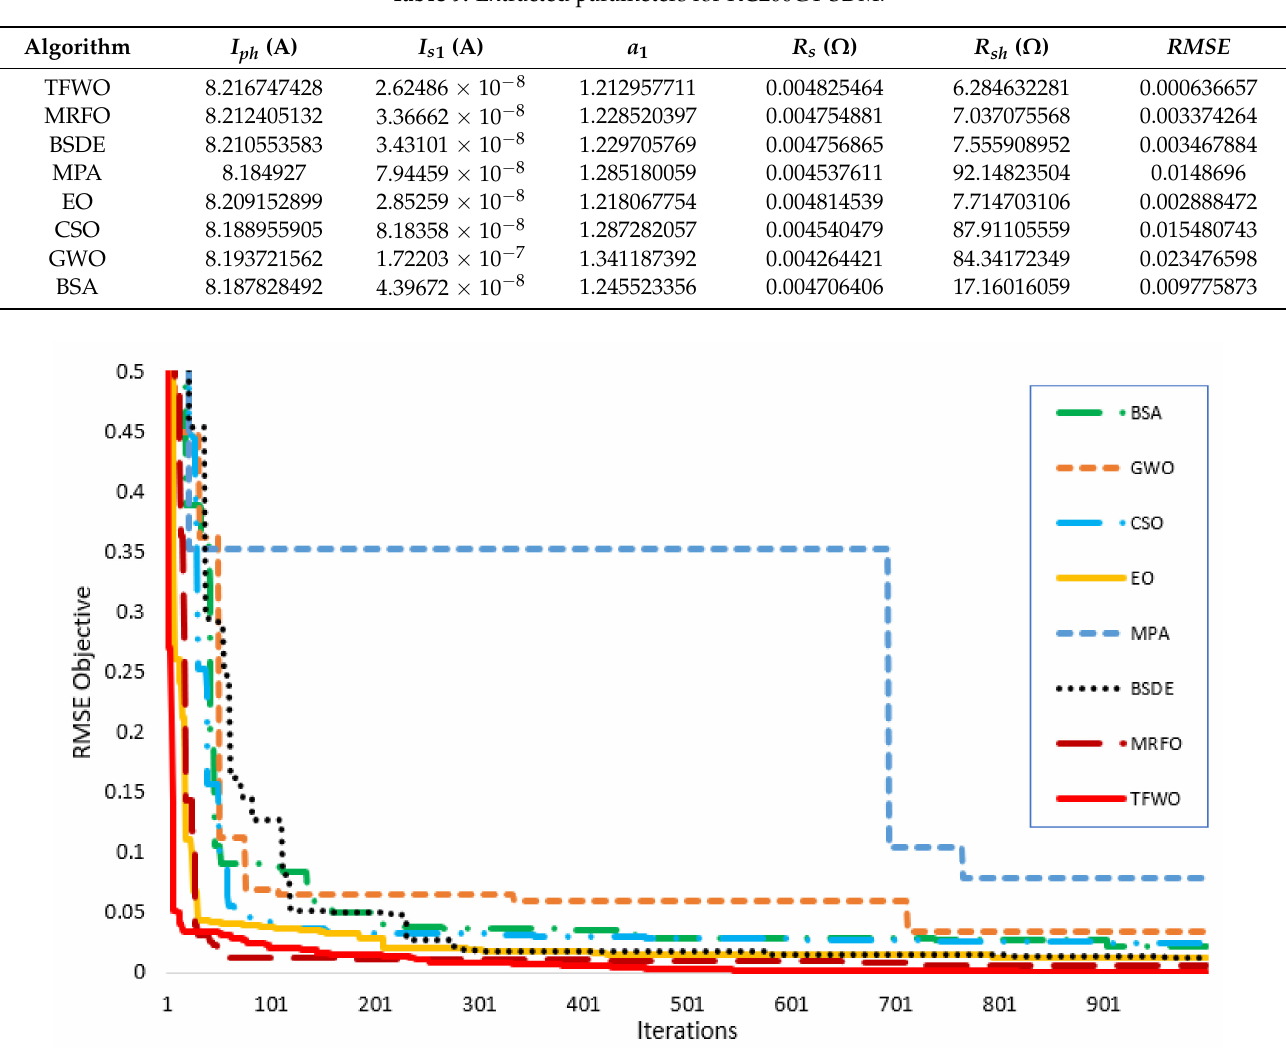
Table 9. Extracted parameters for KC200GT SDM.